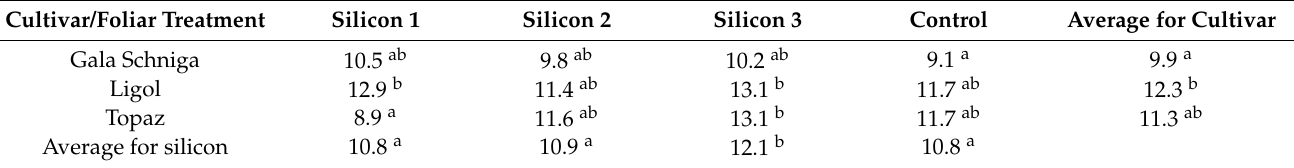
Table 6. The yield of fruits per tree depends on cultivar and foliar silicon treatment (kg).